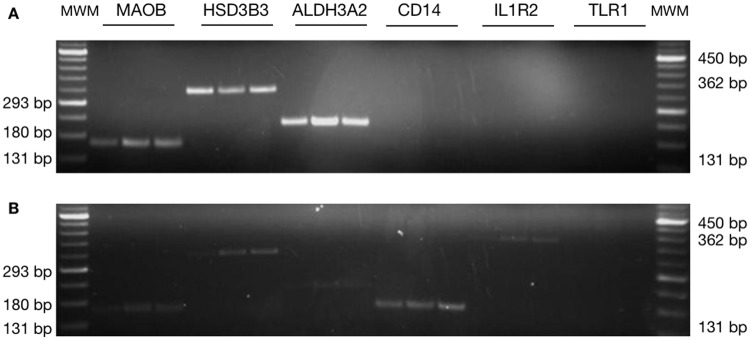
The microarray was validated with PCR reactions.(A) PCR amplification from liver RNA samples for the selected genes at time t0 (before any treatment). (B) PCR amplification at t21 (21 days after oral infection of mice with F. hepatica metacercariae). Three up-regulated genes and three down-regulated genes were randomly chosen for PCR amplification. The corresponding PCR for each gene was performed using each biological sample obtained at t0 and t21. The results are representative of three individual experiments. MWM: molecular weight marker.